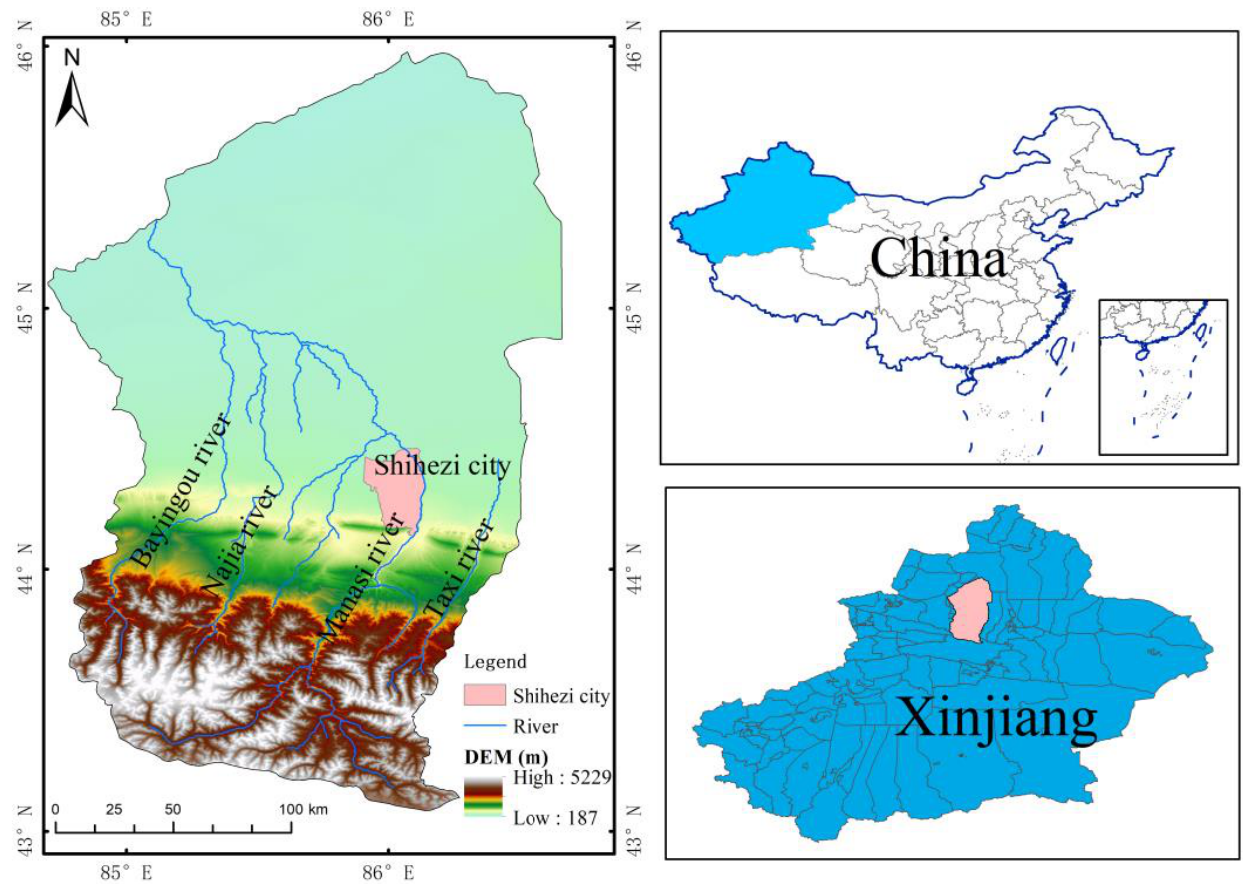
Figure 2. Geographical map of the study area.